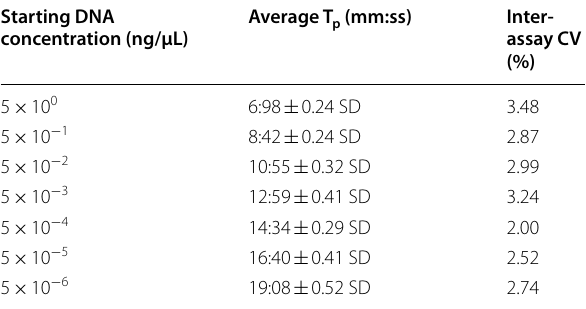
Table 2 Inter-assay co-efficient of variation of A. tomentosa gDNA serial dilutions using LAMP Starting DNA concentration (ng/μL)